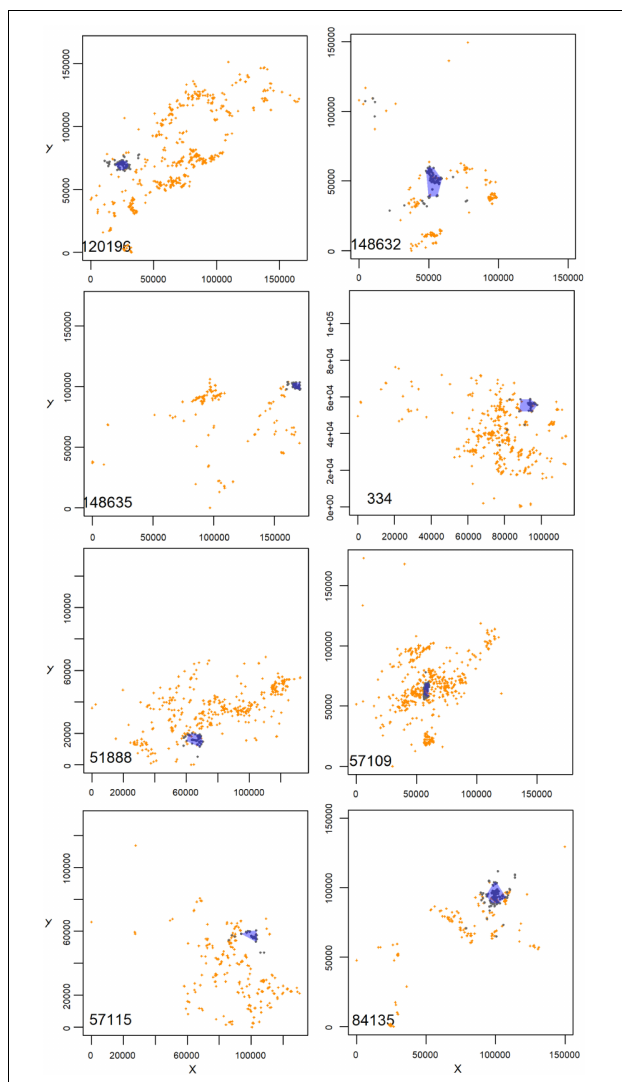
FIGURE 2 | Example plots for eight tagged birds (identified, bottom left in each panel) of Minimum Convex Polygons (MCPs) (in blue transparency) for median nocturnal records post-putative settlement date (dark blue) and with comparable records pre-settlement date (orange) for tagged birds deemed to have settled according to the algorithm. Axes have been re-scaled to zero at origin so as not to reveal geographically explicit reference, for reasons of confidentiality on territory locations. The R code in Supplementary Appendix B provides for such